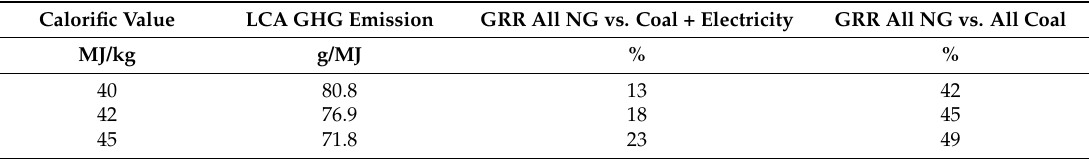
Table 11. Results of GHG emissions GRR for LNG pathway under different assumptions of LNG calorific